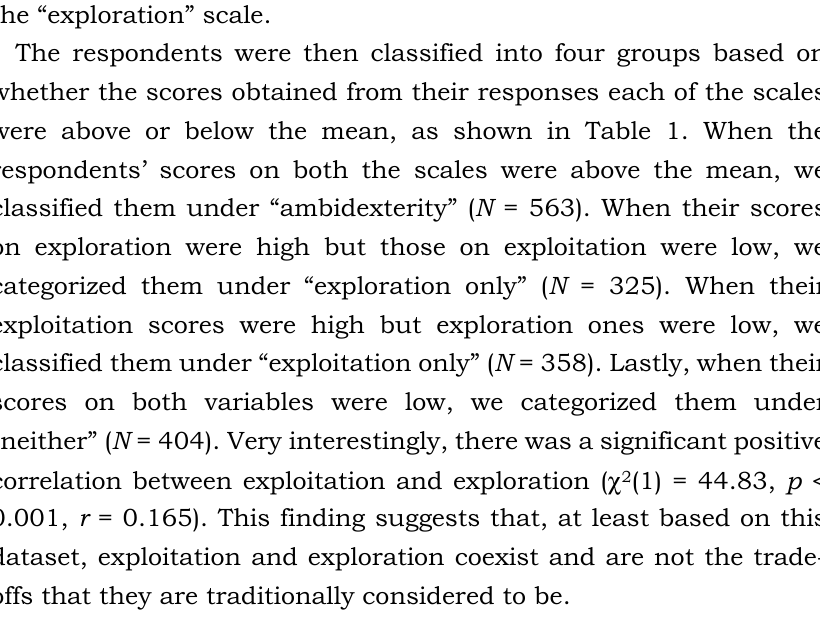
Table 1. Relationship between exploitation and